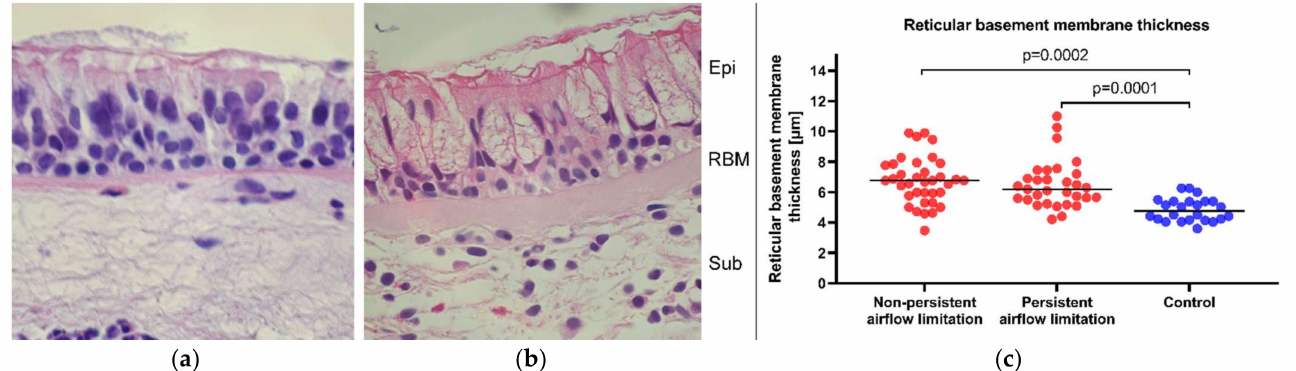
Figure 3. Reticular basement membrane (RBM) thickness measurements. The representative photomicrograph of hema- toxylin and eosin-stained bronchial mucosa specimen from ( a ) a control individual and ( b ) an asthma patient—the picture depicts typical asthma remodeling changes, including mucus cell hyperplasia and RBM thickening; abbreviations: Epi— epithelial cells, RBM—reticular basement membrane, Sub—submucosa; ( c ) RBM measurements in all three analyzed groups; n = 35 non-persistent airflow limitation patients, n = 36 persistent airway obstruction patients, and n = 24 control. Statistics: one-way covariance analysis (ANCOVA) adjusted for age, sex, and body mass index. Table 3. Results of histology investigations.